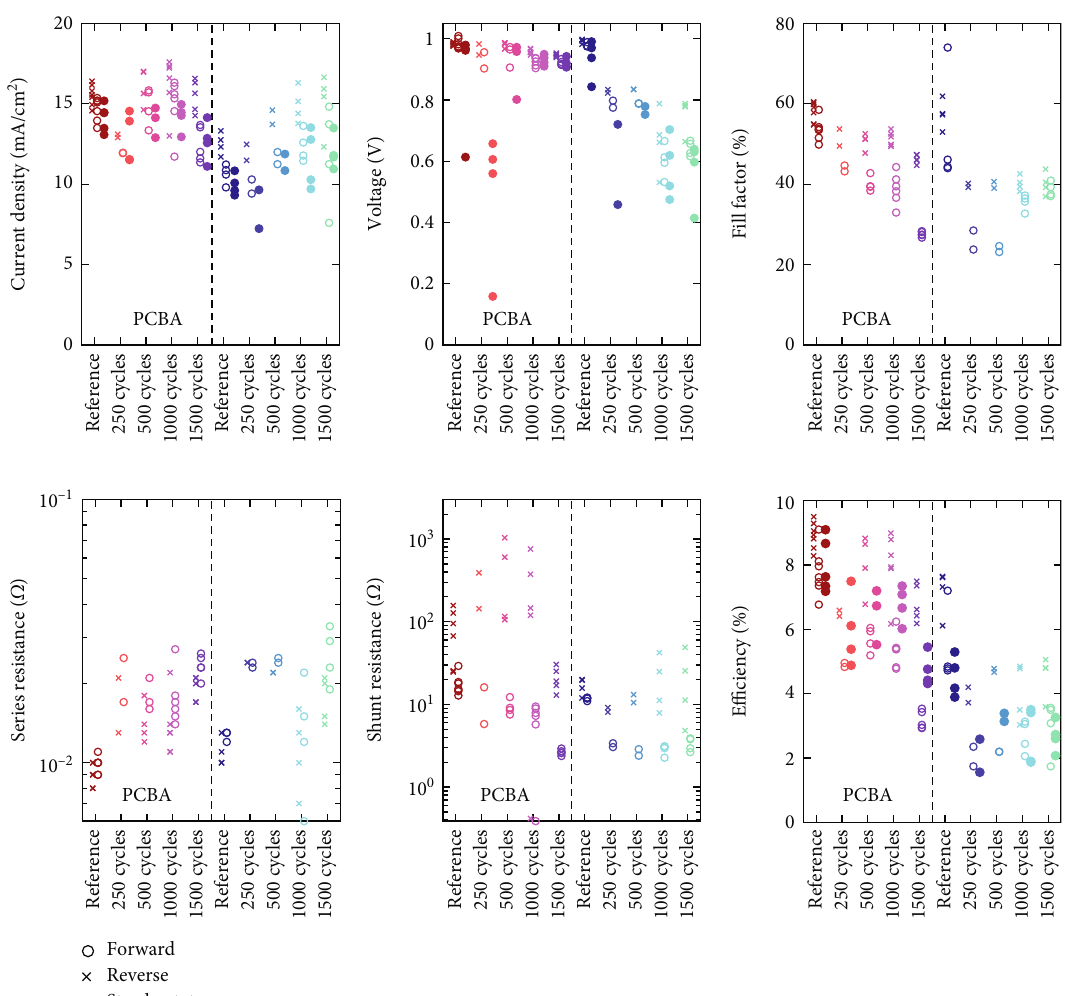
Figure 6: Thickness dependent solar cell characteristics for PCBA modi fi ed (left) and unmodi fi ed (right) SALD layers fabricated at 200 ° C. Reference layer were fabricated with a commercial sol-gel. Solar cells have been measured in forward (open circle), reverse (x), and under steady state conditions ( fi lled circle). The di ff erent panels show the J SC , V OC , Fill factor ( FF ), R series , R Sh , and the power conversion e ffi ciency,